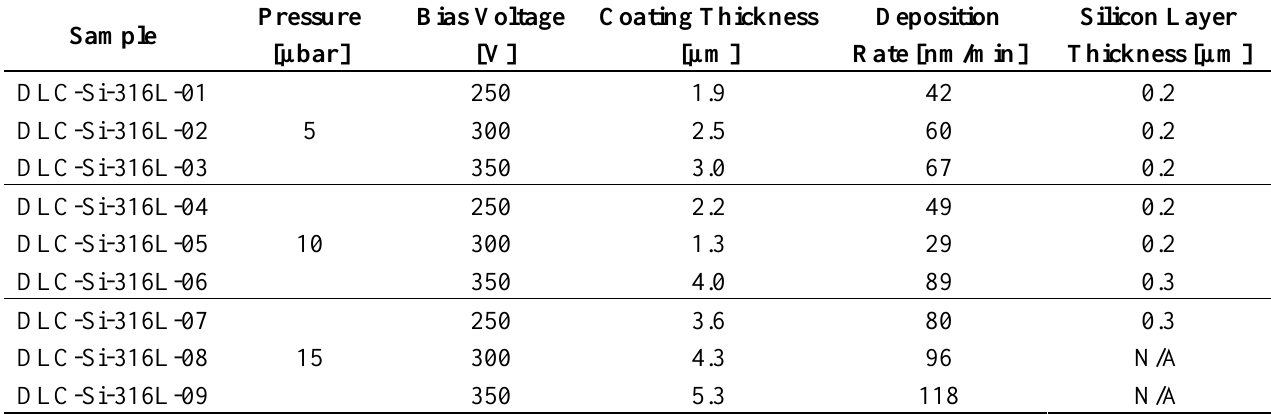
Table 1. Sample identification, process variables, deposition rates, coating and transition layer thicknesses for diamond like carbon (DLC) coatings deposited with Si interlayers at varying bias voltage and gas